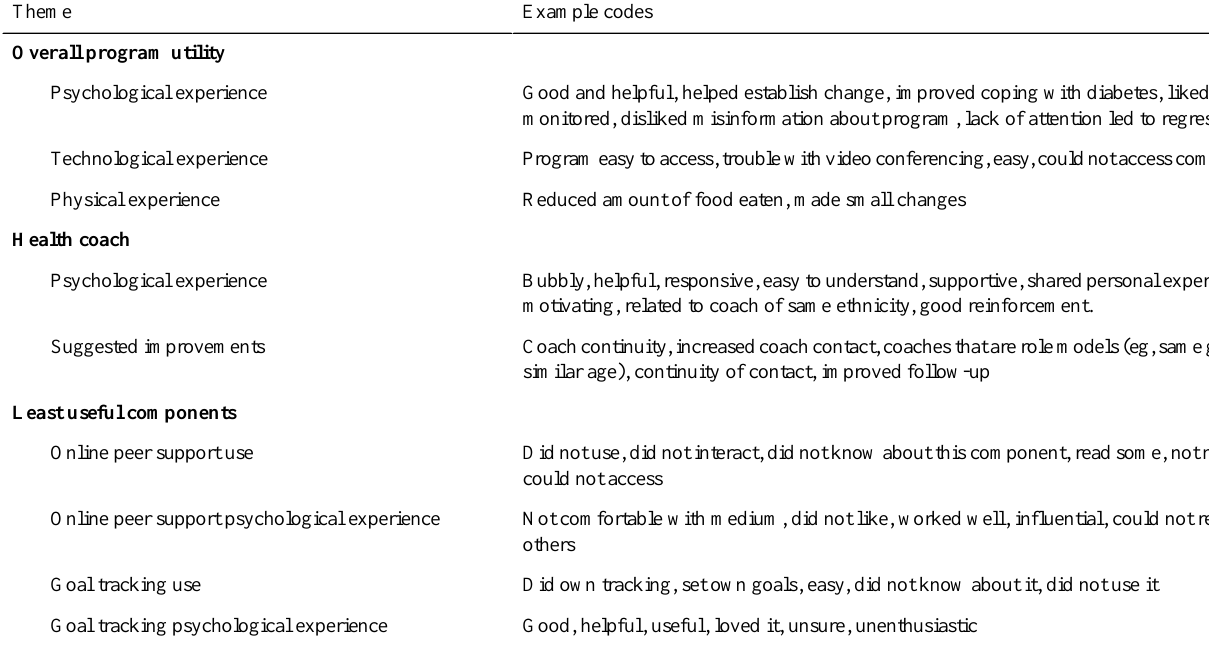
Table 2. Coding framework extract with example categories and